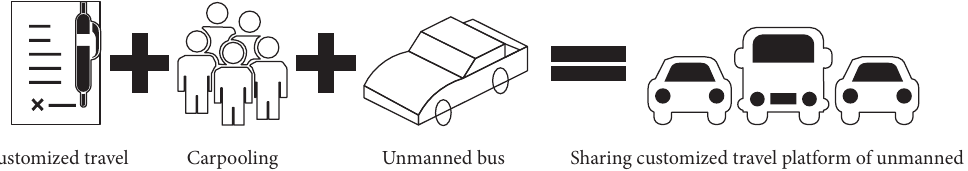
Figure 2: Design of customized travel platform for unmanned